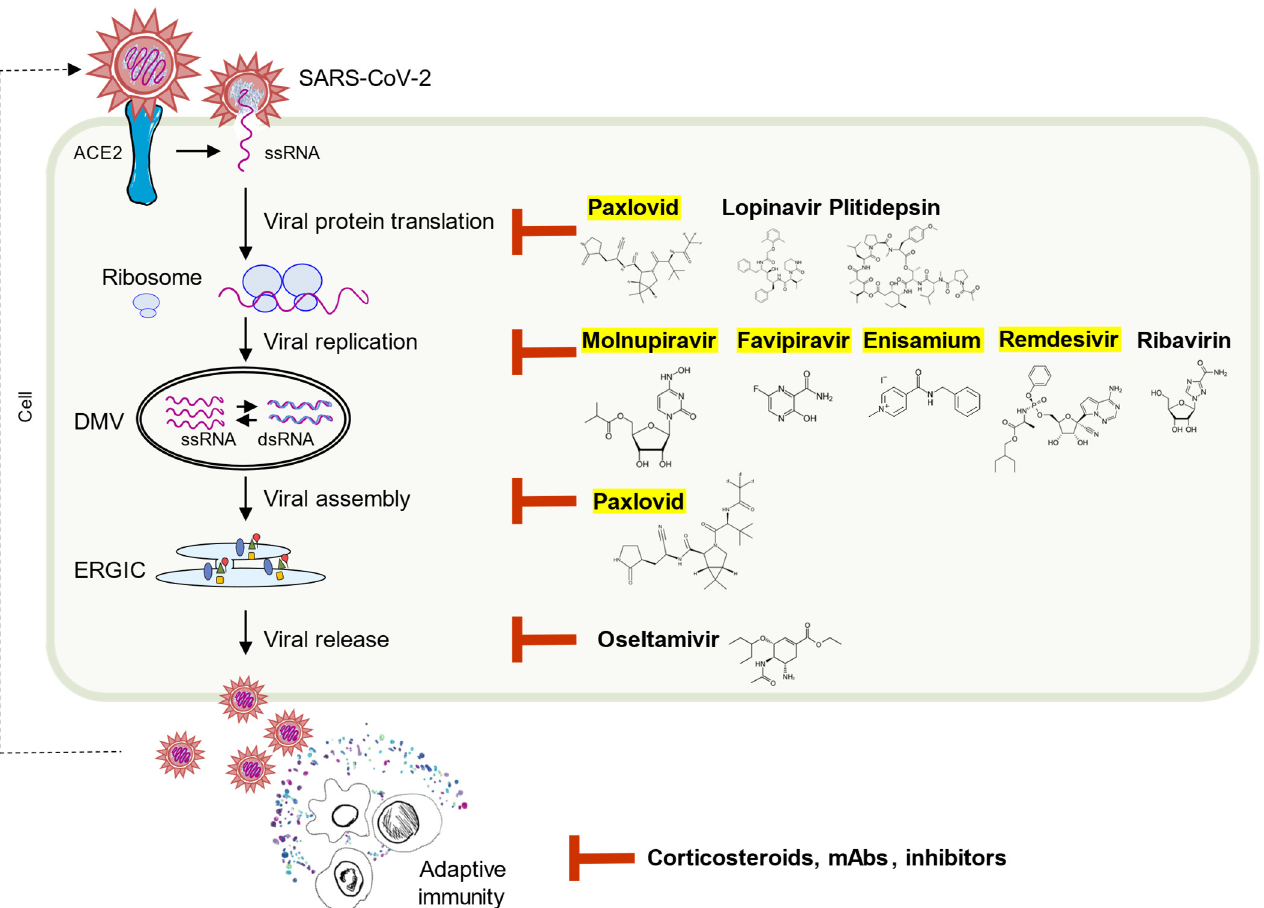
Figure 3. Therapeutics used against SARS-CoV-2 infection. Pharmaceuticals that can potentially inhibit the replication stages of RNA virus during its infection are labeled with their molecular formula. Red bar-headed lines indicate the inhibition effect of the drug. Anti-COVID-19 drugs are highlighted in yellow.